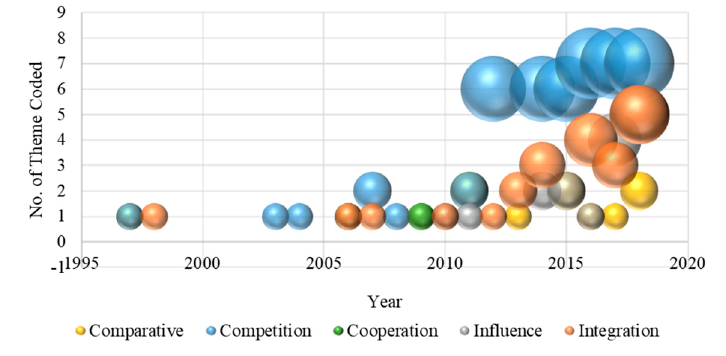
Figure 4. Trend in Research